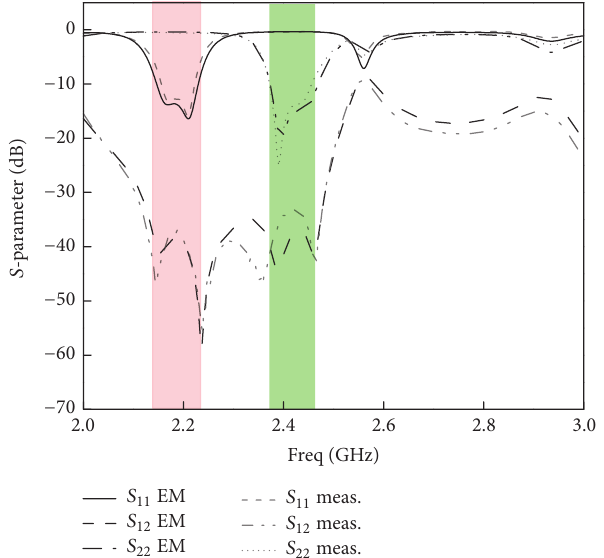
Figure 10: Simulated and measured realized antenna